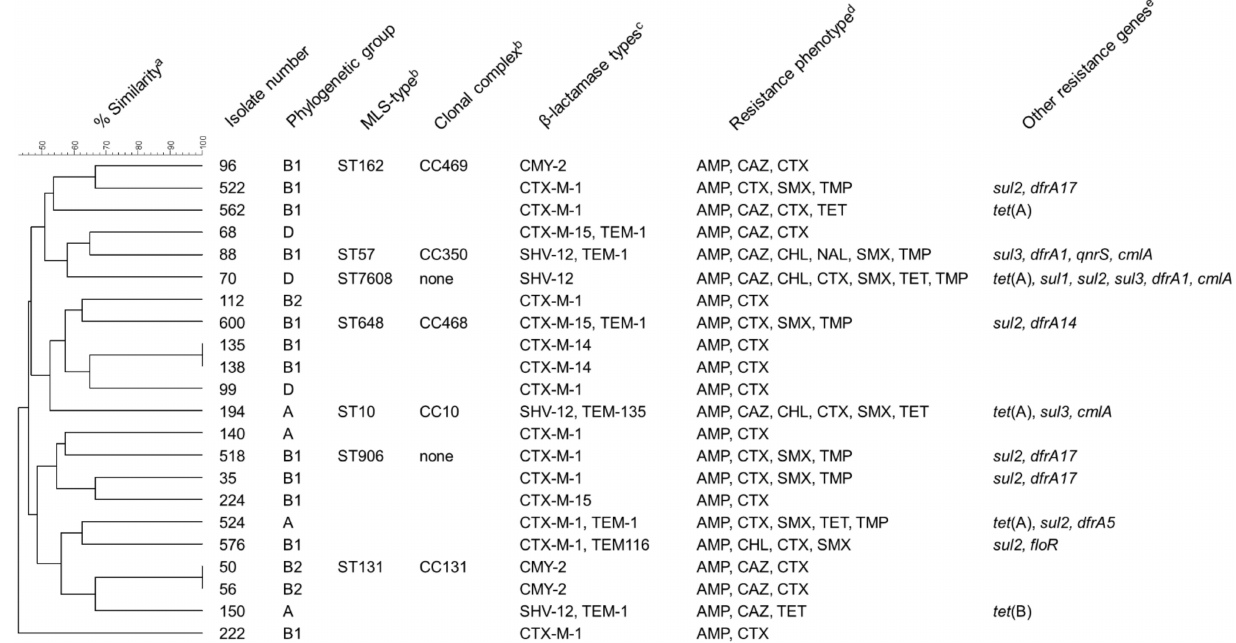
Figure 2. Characteristics of E. coli isolates collected in the course of the present study. a Dendrogramm depicting the relatedness of the isolates and the percentage of similarity based on PFGE band patterns after Xba I digestion. b Multilocus sequence types and clonal complexes according to genome sequences. These data are only available for isolates subjected to genome sequencing. None: ST does not belong to a defined clonal complex. c Includes ESBLs, AmpC- β -lactamases and additional non-extended-spectrum β -lactamases (TEM-1, TEM-116, TEM-135). d Resistance phenotype based on MICs determined by broth macrodilution susceptibility testing and evaluation according to CLSI breakpoints for E. coli . AMP = ampicillin, CAZ = ceftazidime, CHL = chloramphenicol, CTX = cefotaxime, NAL = nalidixic acid, SMX = sul- famethoxazole, TET = tetracyclines, TMP = trimethoprim. e Resistance genes other than β -lactamase genes detected in the isolates by